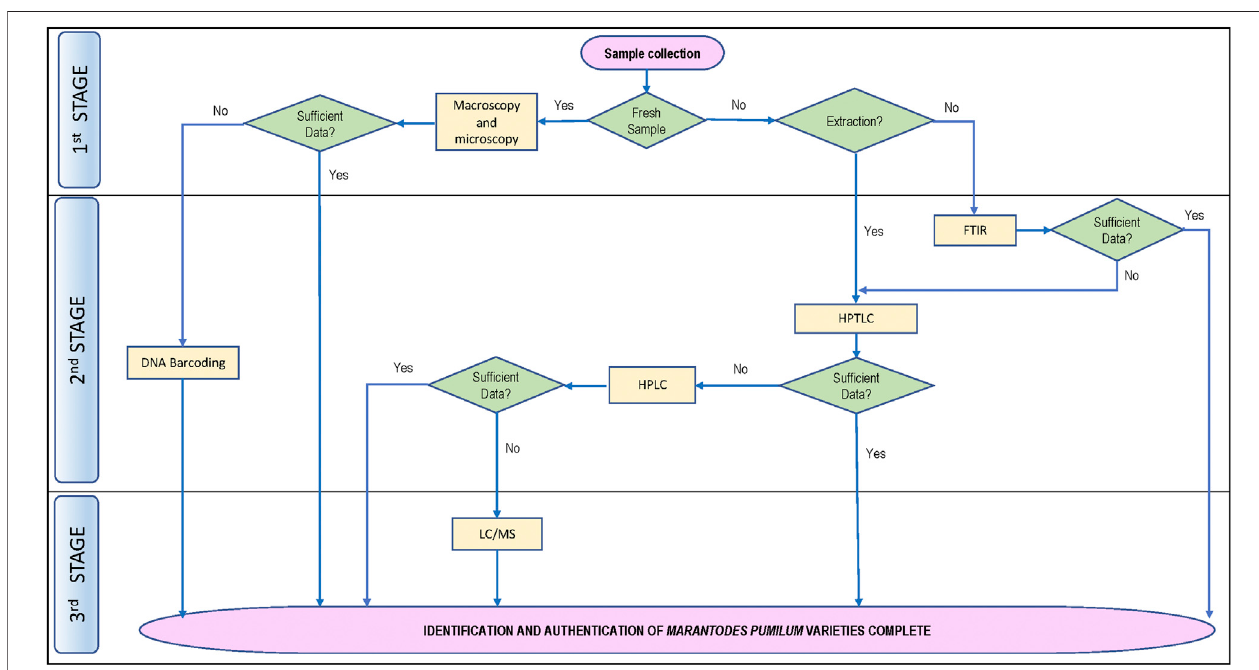
FIGURE 4 | Proposed fl ow chart for authentication of Marantodes pumilum